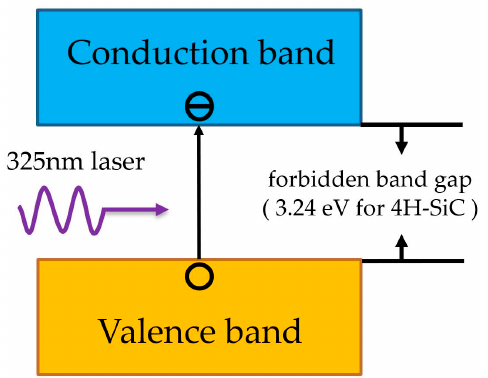
Figure 2. Schematic of 4H-SiC photo-generated carrier phenomenon.